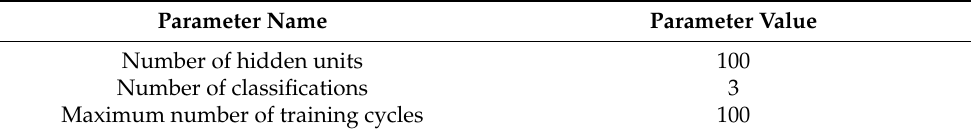
Table 2. Parameter settings for network identification.